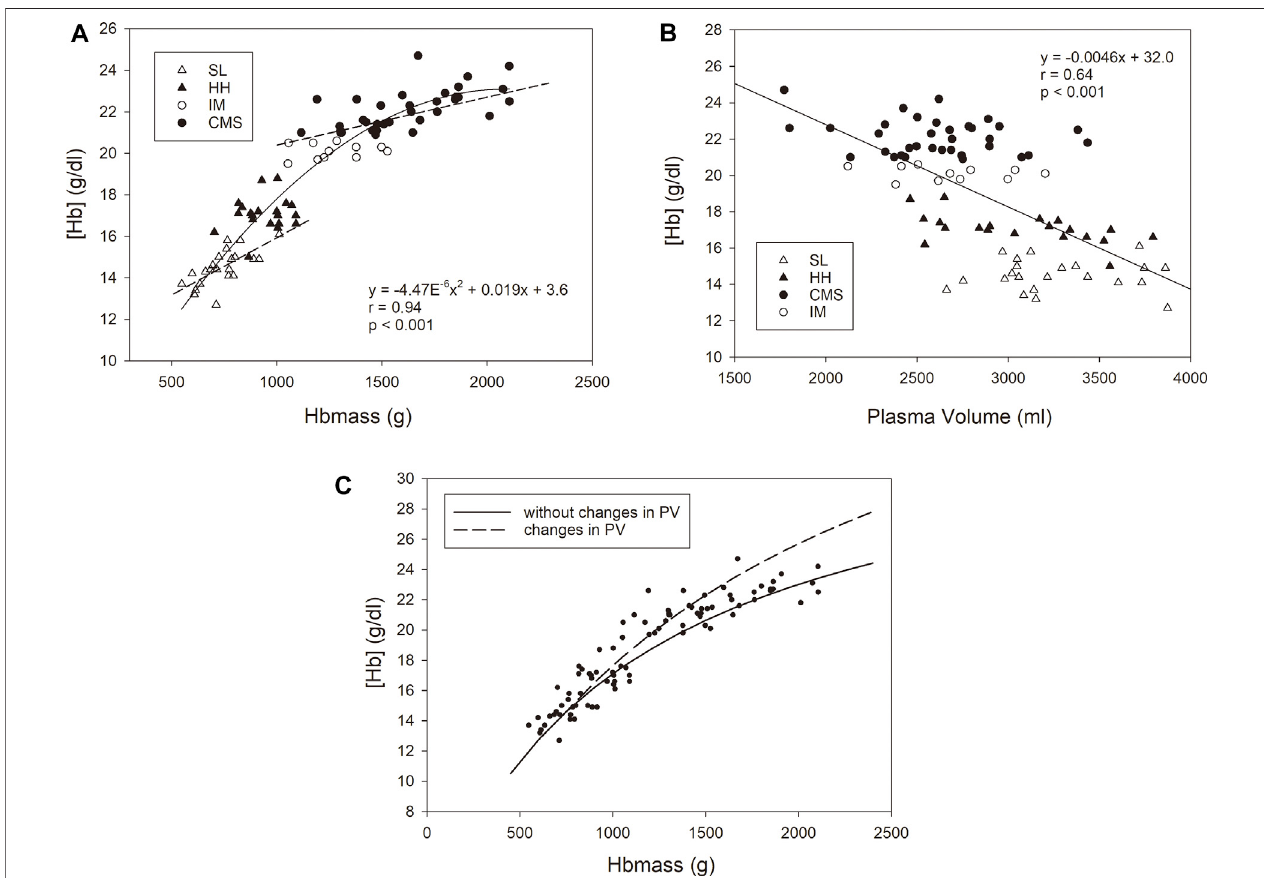
FIGURE 3 | Relationship between [Hb] as the dependent variable and Hbmass (A) and plasma volume (B) as independent variables. The statistical information in the graphsrelates tothe group asa whole. ForHbmass vs. [Hb], signi fi cantassociations were foundfor the CMS group (y= 0.0023x+ 18.4 r =0.63, p < 0.001) and the SL group (y = 0.0053x+ 10.5, r = 0.69, p < 0.001). (C) Relationship between[Hb] and absolute Hbmass calculated for twoconditions withrespect tothe SL group: (i) a constantplasmavolumewithincreasingHbmass(i.e.,3,300 ml,correspondingtothemeanvalueoftheSLgroup); (ii) adecreasingplasmavolumewithincreasing Hbmass (dashed line). A reduction in PV of 80 ml per 100 g Hbmass above an Hbmass of 740 g (corresponding to the mean value of the SL group) was assumed. The reduction inPV iscalculated from the average decrease in PV ofall three altitudegroups relativeto theSL group. The dots represent the values determined in